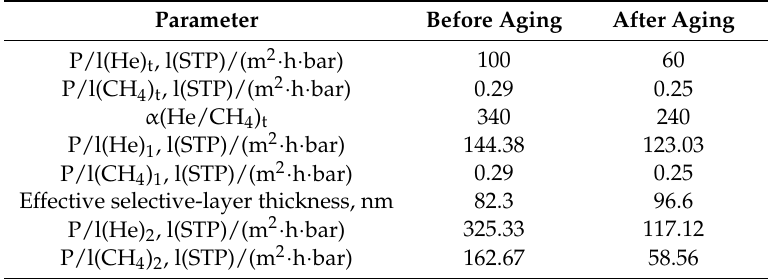
Table 2. Permeances of selective and support layers, for aged and non-aged hollow fibers, calculated using resistance models.